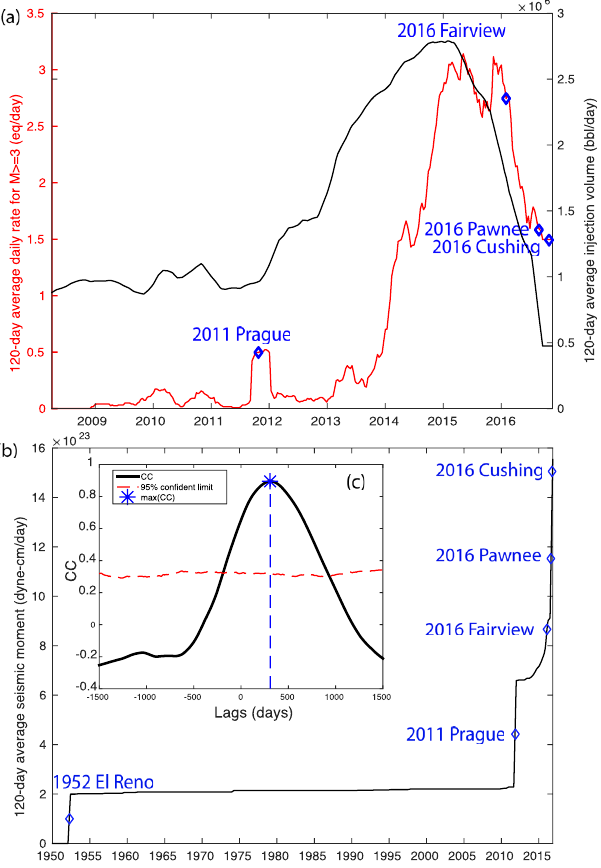
Figure 2. Overview of the relationship between injection and seismicity for Oklahoma. ( a ) Black line shows the history of state-wide daily injection rate (averaged per 120 days) and red line shows the state-wide daily earthquake rate for M ≥ 3 earthquakes (averaged per 120 days). Dashed lines show the three M5 sequences since 2010. ( b ) History of cumulative moment release in Oklahoma. The four major sequences are shown with blue diamonds, and corresponding names are labeled. The inset shows the cross-correlation between injection rate and seismicity rate. The blue dashed line shows the lag at maximum correlation. The red line shows the 95% confidence limit of